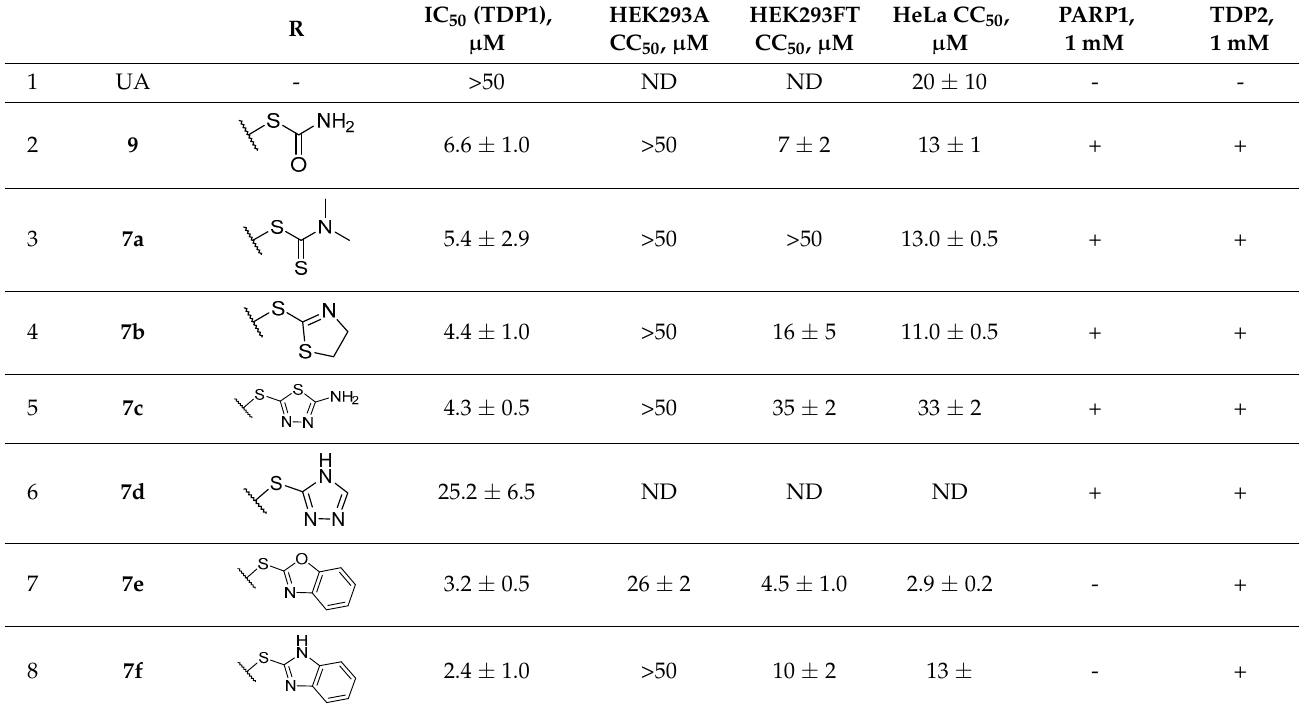
Table 1. TDP1, TDP2, and PARP1 inhibition ability and cytotoxicity of the thioether UA derivatives.